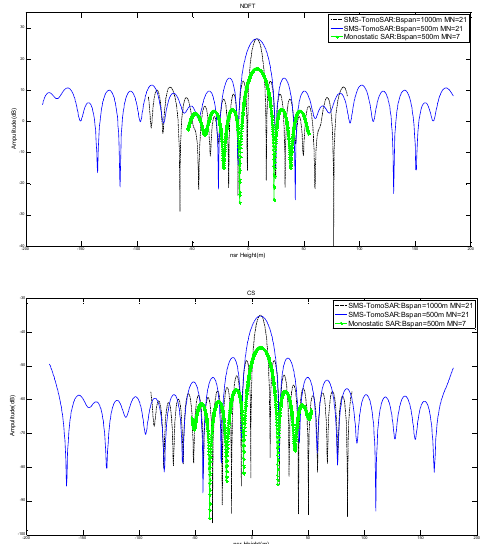
Figure 11. The imaging results of SMS-TomoSAR and monostatic SAR. Table 4. The imaging performance results of SMS-TomoSAR and monostatic SAR for the NDFT and CS algorithms.